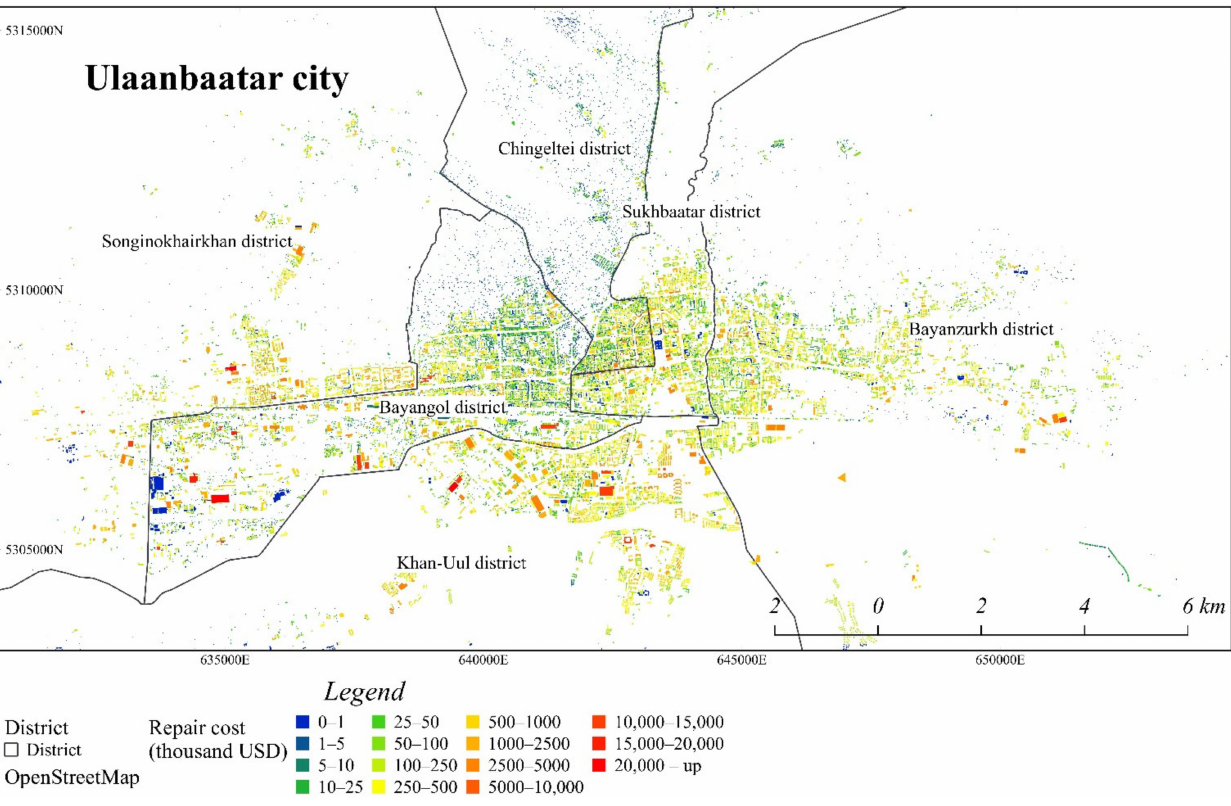
Figure 16. Distribution of building losses (repair costs in thousand USD) in